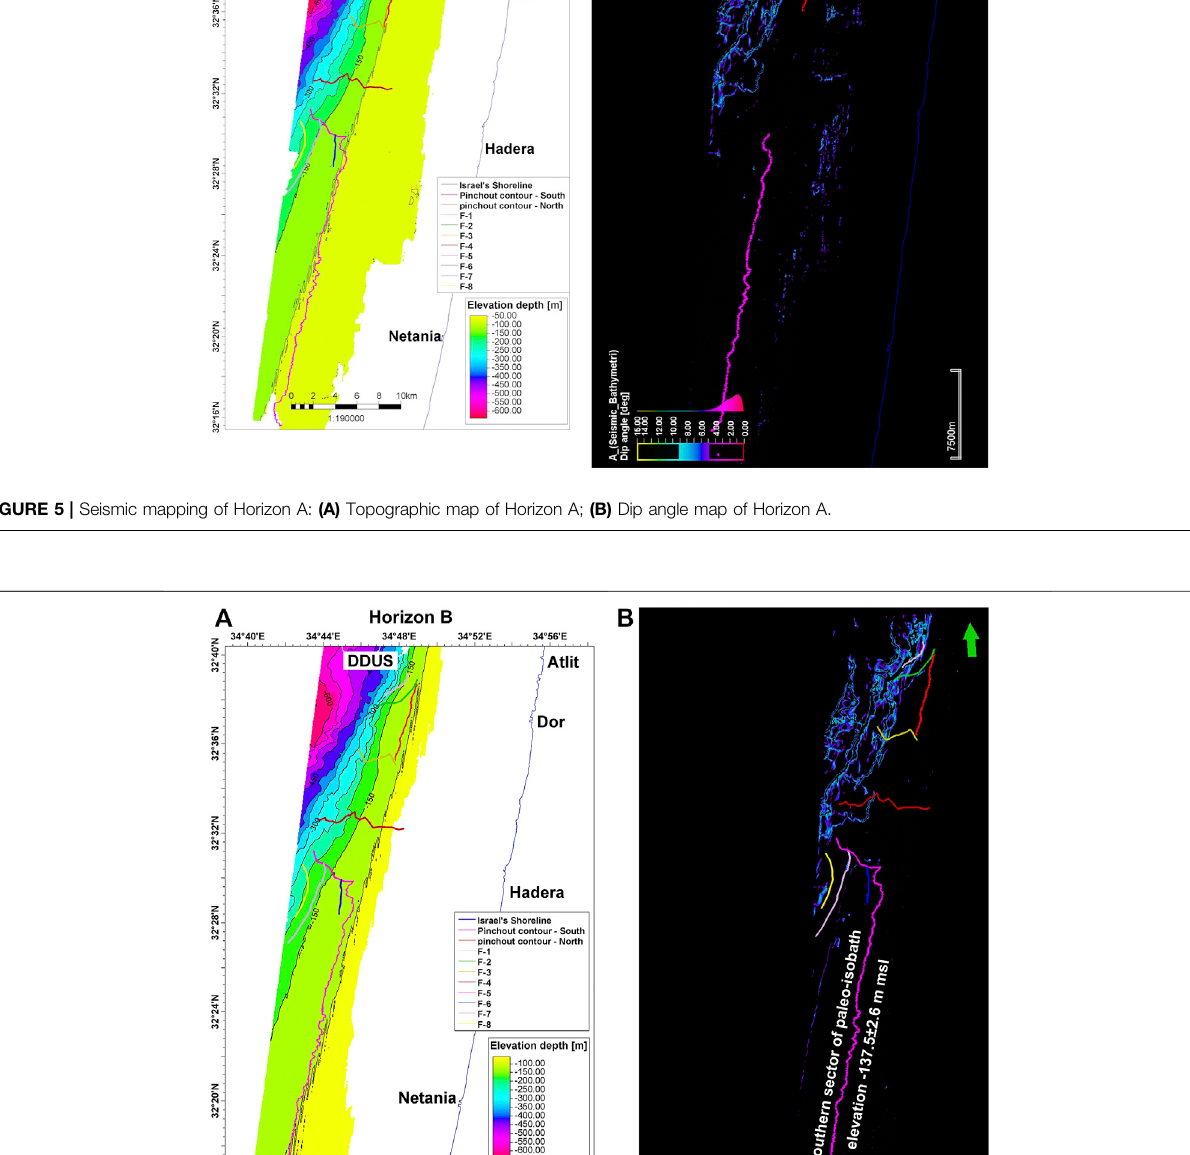
Frontiers in Earth Science |